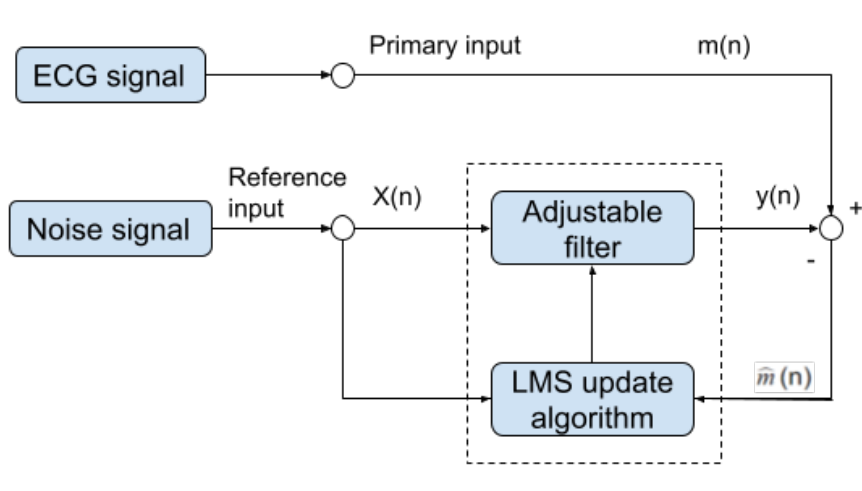
Figure 10. Block diagram of our noise removal adaptive filter.